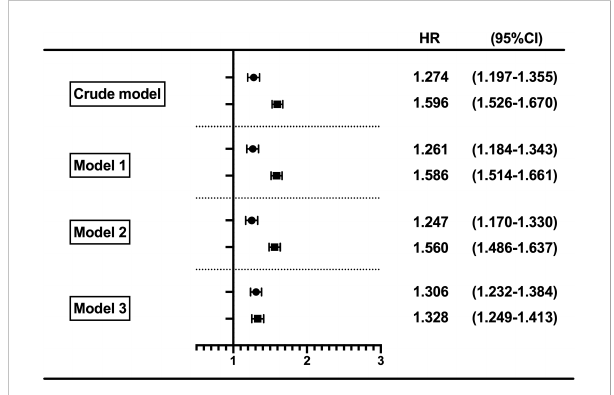
FIGURE 4 Forest plot of HRs for incident diabetes per SD difference in HGI and HbA1c. Circles represent HGI, and squares represent HbA1c in different Cox regression models. Model 1 was adjusted for age and sex. Model 2 was adjusted for the variables in model 1 plus body mass index, systolic blood pressure, diastolic blood pressure, hypertension, antihypertensive medication, total cholesterol, triglycerides, and low-density lipoprotein cholesterol. Model 3 was adjusted for all variables in model 2 plus the baseline fasting plasma glucose and 2-h plasma glucose at the OGTT. CI, con fi dence interval; HbA1c, hemoglobin A1c; HGI, hemoglobin glycation index; HR, hazard ratios; OGTT, oral glucose tolerance